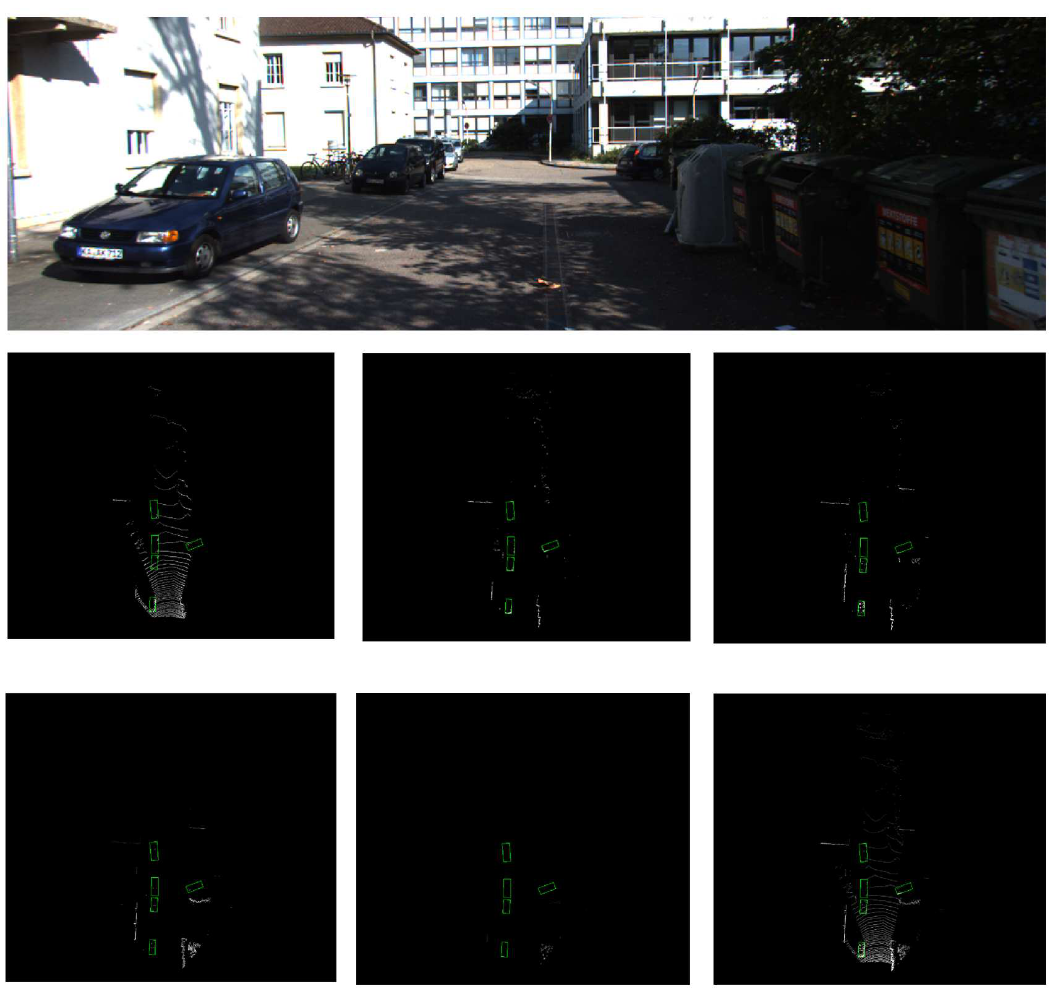
Figure 5. ( Top ) Image to be tested; ( Middle ) from left to right are the first three heigh feature maps; and ( Bottom ) the first two are height feature maps, and the last one is density feature